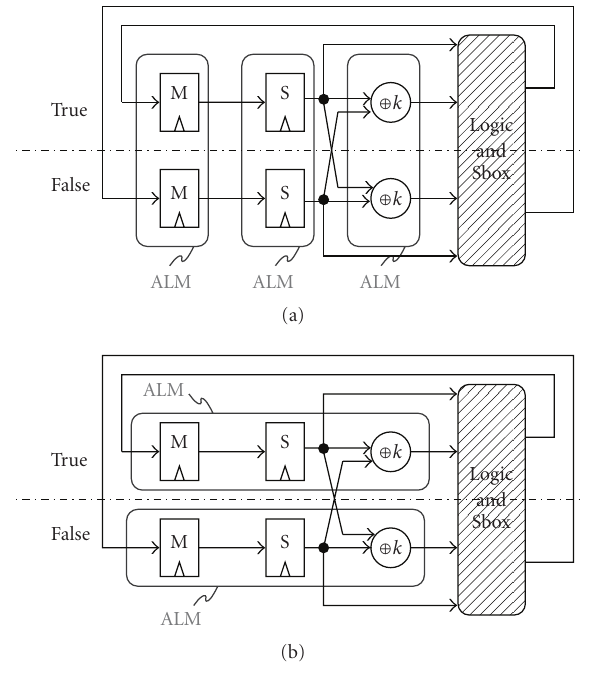
Figure 7: Vertical (a) and Horizontal (b) PAR strategies.